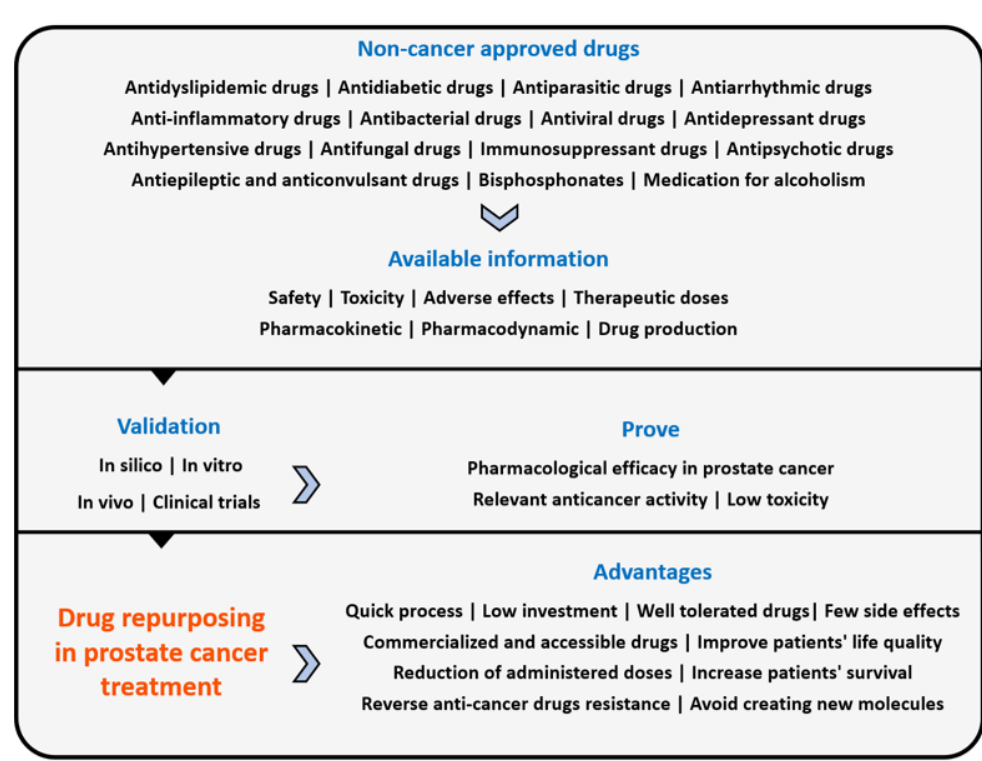
Scheme 1. Repurposing drugs process in prostate cancer and its advantages. Non-cancer